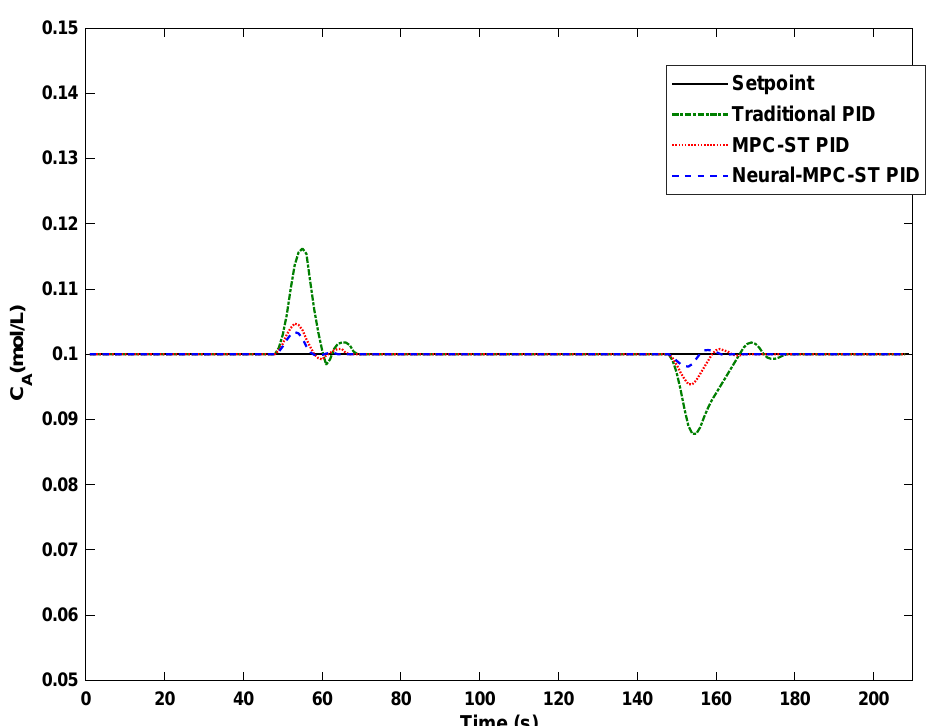
Figure 8. Control signal related to applied temperature